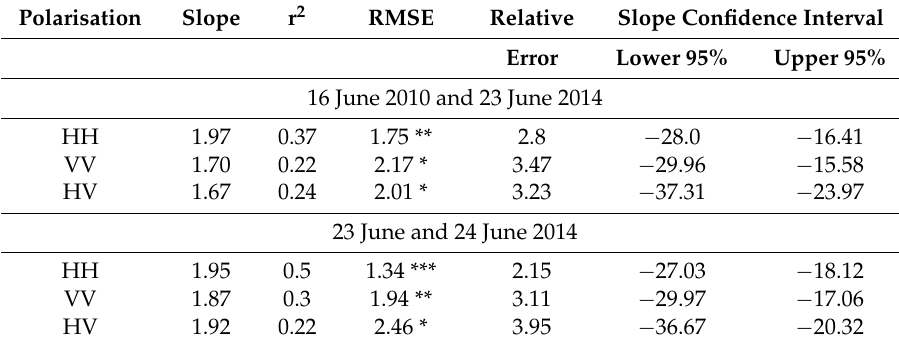
Table 8. Results from the regression models relating S-band backscatter ( σ °) acquired in 2010–2014 to plot biomass from combined sites.